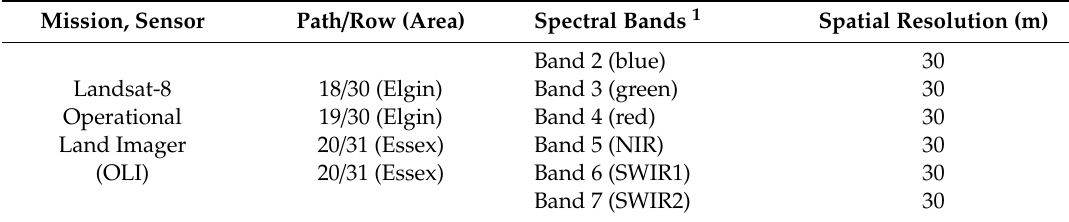
Table 1. Acquisition characteristics and spectral bands of the satellite scenes used in the study. Mission, Sensor